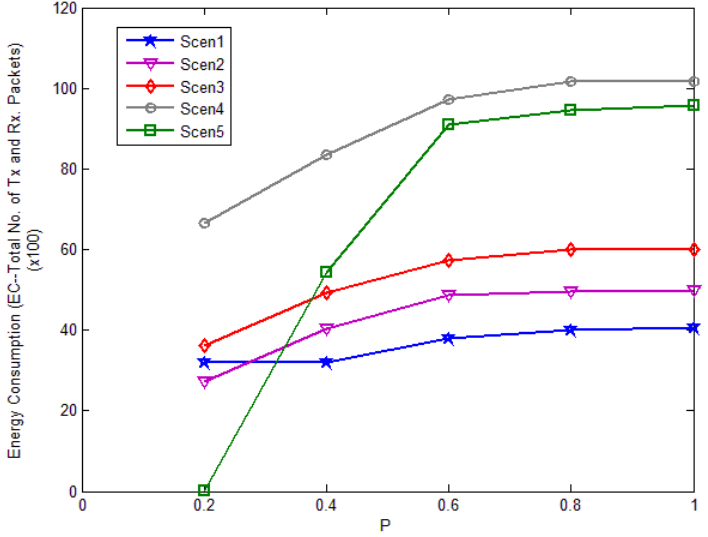
Figure 20. Energy consumption in each scenario against threshold